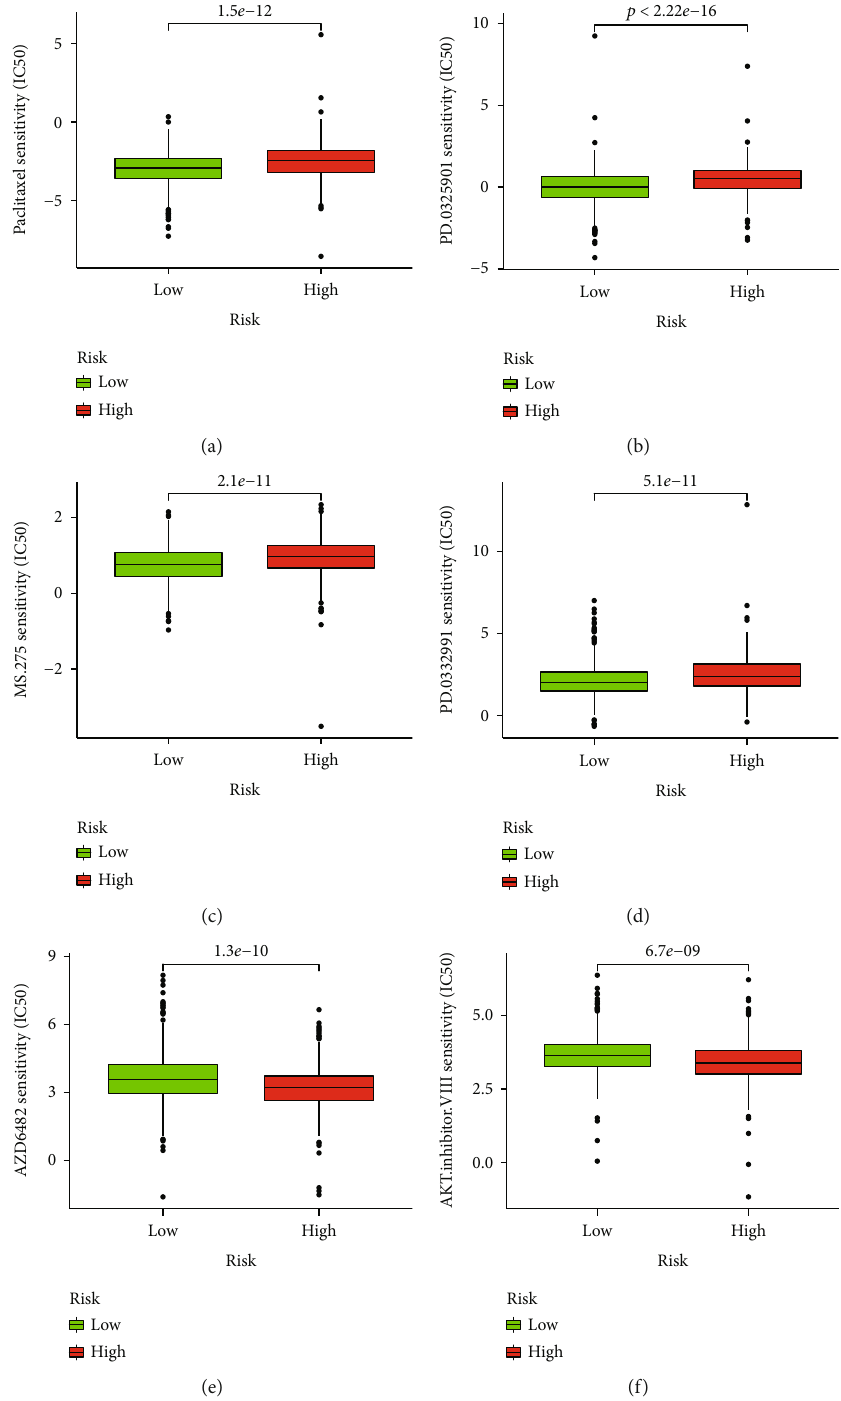
Figure 11: Comparison of drug sensitivity between high-risk and low-risk groups. IC50 of paclitaxel (a), IC50 of CDK4/6 inhibitors (b), HDAC inhibitors (c), MEK inhibitors (d), PI3K inhibitors (e), and Akt inhibitors (f) in high-risk and low-risk